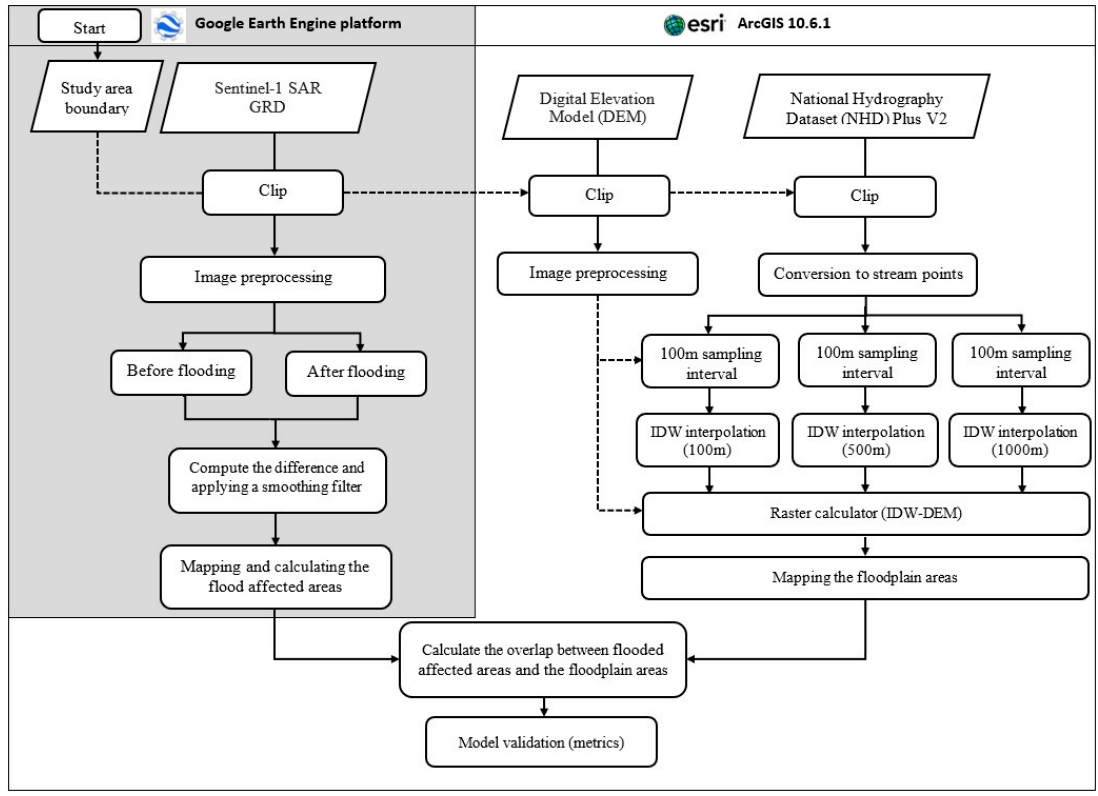
Figure 2. A flow diagram for data processing and the analysis steps. Explains data processing and the analysis steps carried out in this